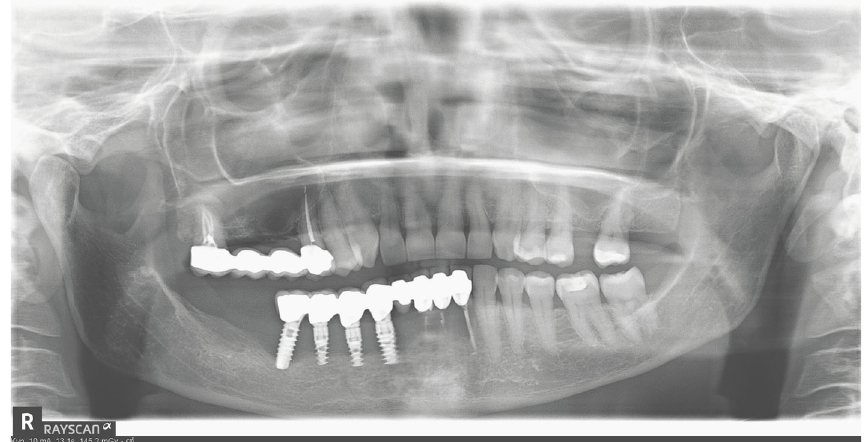
Figure 5: Six months after implant surgery: peri-implantitis a ff ects new implants and tooth resorption involved the teeth up to the 3.3.